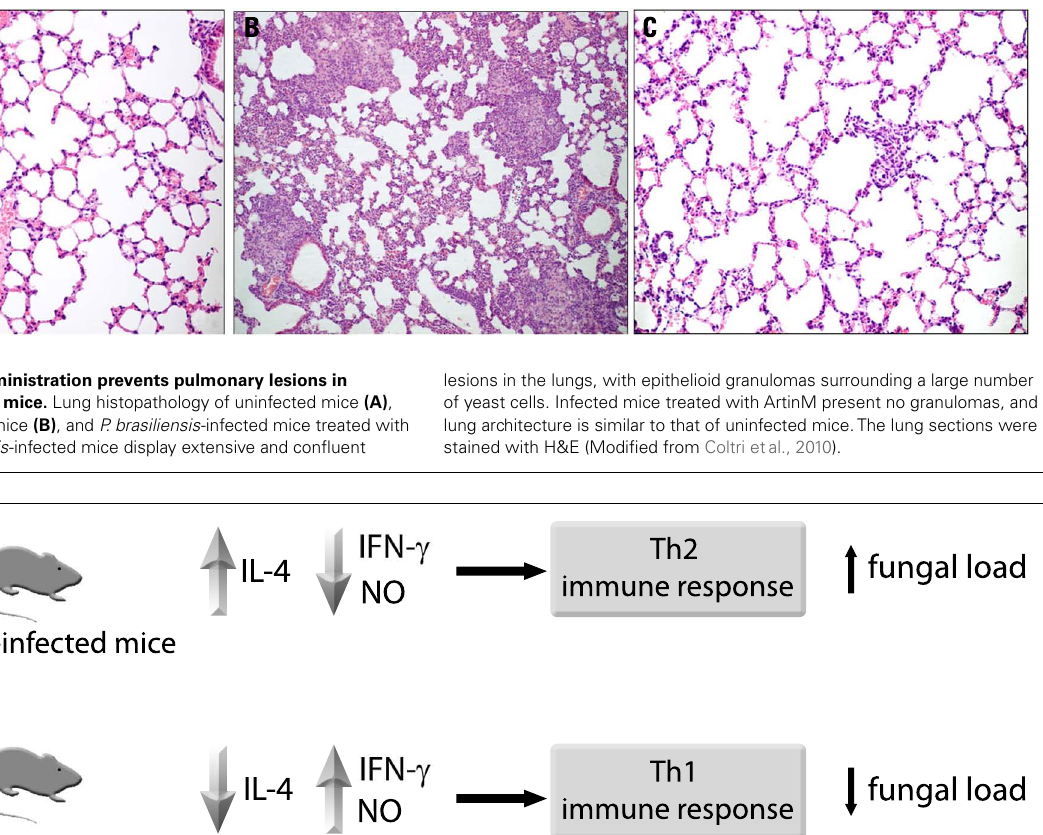
IL-4, IFN- γ and NO concentrations. ArtinM treatment was associated with lower IL-4 and higher IFN- γ and NO pulmonary levels, which reflected in lower fungal